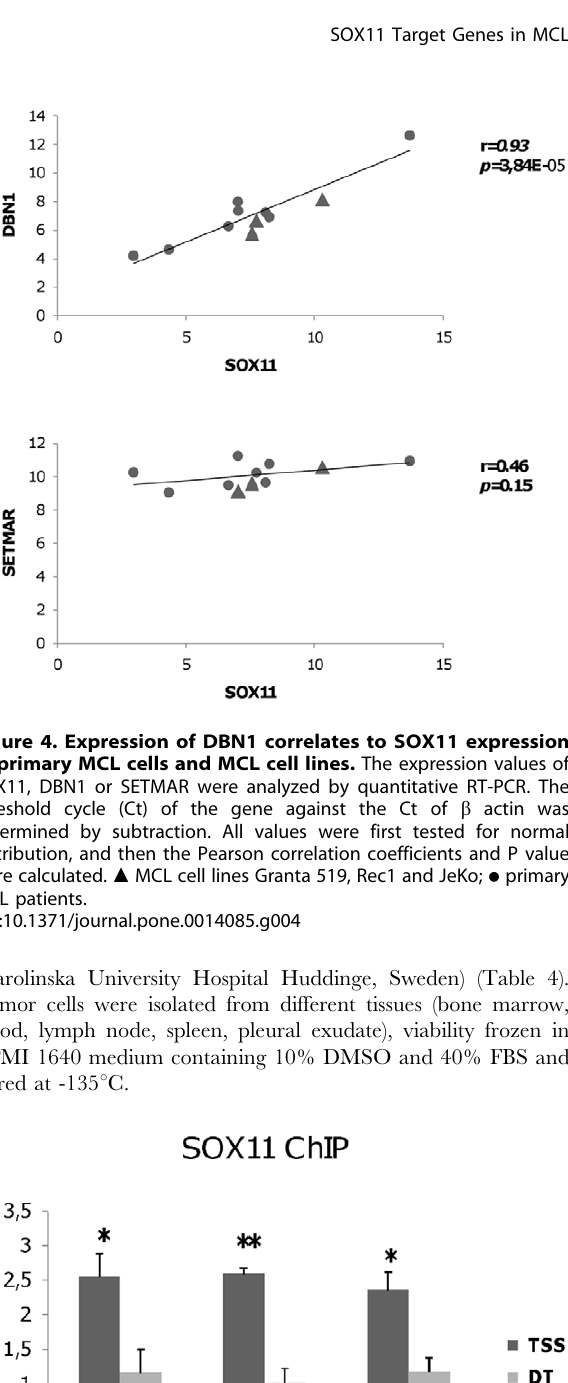
Figure 5. SOX11 protein directly targets DBN1, SETMAR and HIG2. ChIP assay of SOX11 protein binding to the selected three genes. Immunoprecipitated DNA was analyzed by quantitative RT-PCR for two different primers as described in material and method. TSS: primer designed close to transcription start site (TSS) and DT: primer distal ( , 2 kb) to the TSS. Columns represent the mean of fold enrichment of DBN1, SETMAR or HIG2 relative to IgG control. Error bars show standard deviation of 3 independent experiments.* P , 0.05, ** P , 0.01 compared to the IgG control.